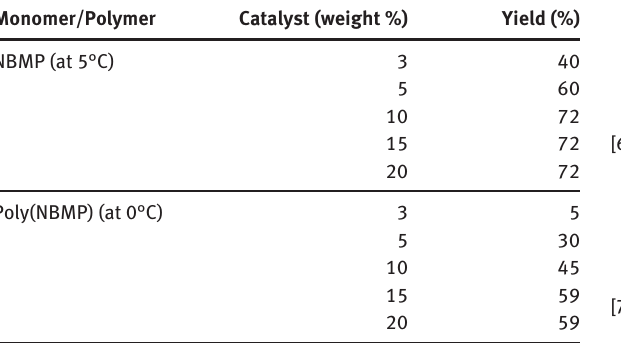
Table 2: Effect of catalyst amount (maghnite-H + /maghnite-Na + ) on conversion of monomer and